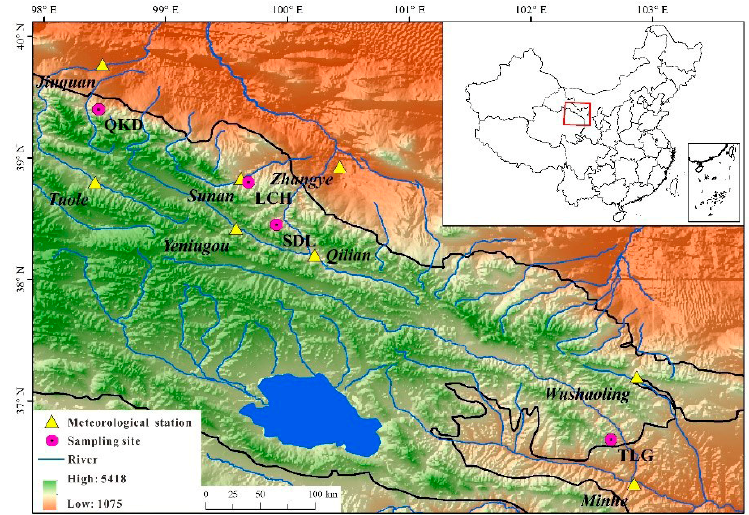
Figure 1. Locations of the sampling regions and nearest meteorological stations in the study area (the Qilian Mountains).